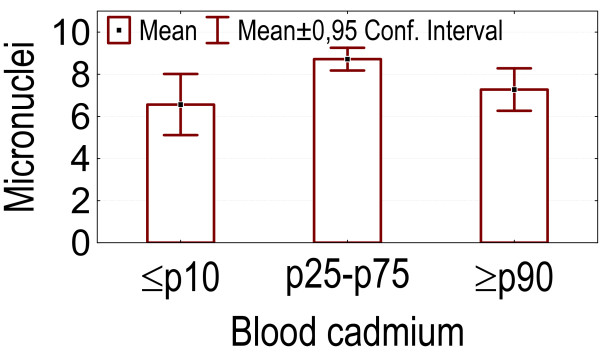
Categories of blood cadmium concentrations: association with the number of micronuclei.